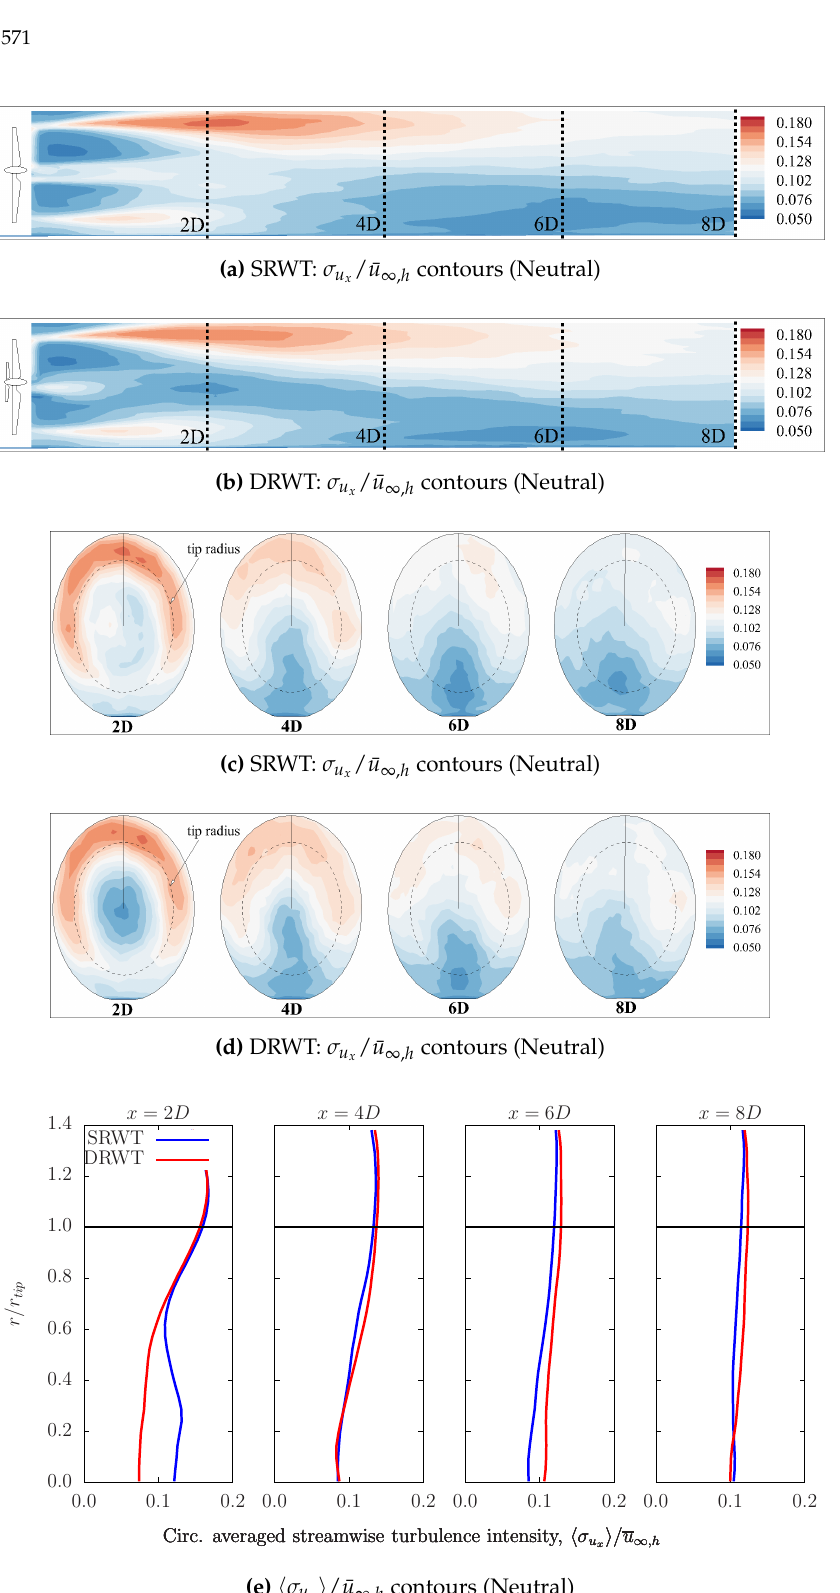
Figure 13. Comparison between SRWT and DRWT of normalized streamwise turbulence intensity, σ u / ¯ u ∞ , h : ( a , b ) on the x - z plane passing through the rotor hub; ( c , d ) on cross-stream ( y - z ) planes; and x ( e ) circumferentially averaged values at four downstream locations ( x / D = 2, 4, 6, and 8) for the neutral ABL